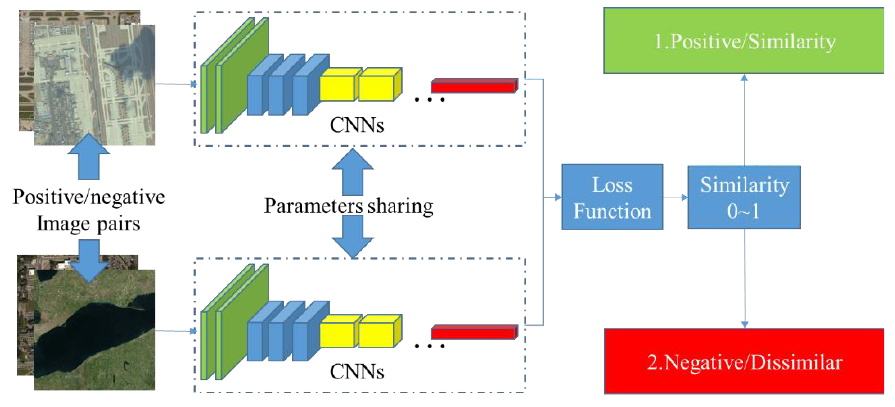
Figure 1. Example of the Siamese Network architecture.